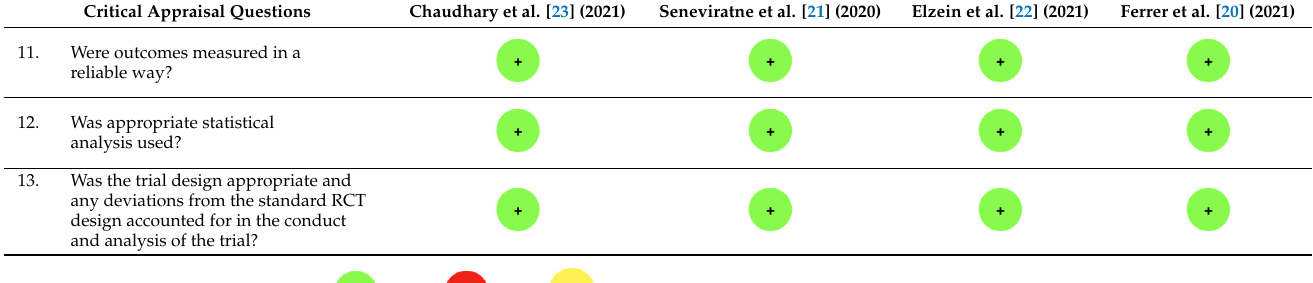
Table 2. JBI Critical Appraisal Tool [19] for RCTs. Reprinted with permission from JBI. Copyright